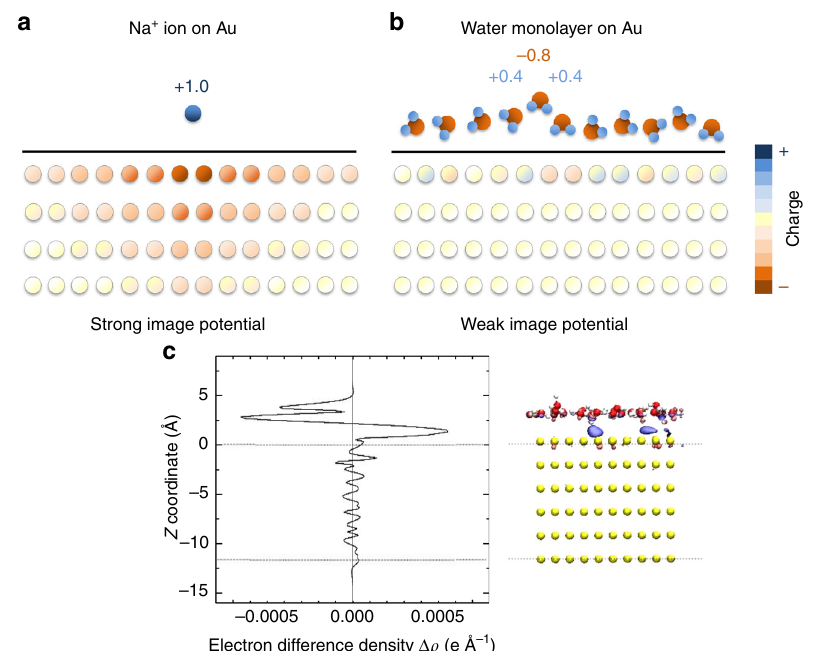
Fig. 4 Origin of major differences in the magnitude of the image potential for isolated ions in the gas phase vs. charge-neutral molecules on gold surfaces. a An isolated ion with a net charge of + 1.0e in the gas phase induces signi fi cant charges in the metal surface that spread across several atomic layers vertically and several nanometers laterally. b In contrast, neutral water molecules in the condensed phase contain dipoles with opposite charges in close proximity, unable to induce a long-range pattern of image charges. Electrostatic interactions are screened and the image potential is more than order of magnitude smaller. The reduction in image potential in ( b ) also applies for metal-oxide and metal-ceramic interfaces. c Electron density difference at the interface of a water monolayer with an Au (111) surface according to DFT (blue = negative charge, isovalue − 0.027e Å − 3 , red = positive charge, isovalue + 0.027e Å − 3 ). Induced charges are small, illustrated by visualization on the right hand side showing some negative induced charge in the vicinity of positively charged hydrogen atoms of water molecules close to the gold surface (blue = negative charge difference, red = positive charge